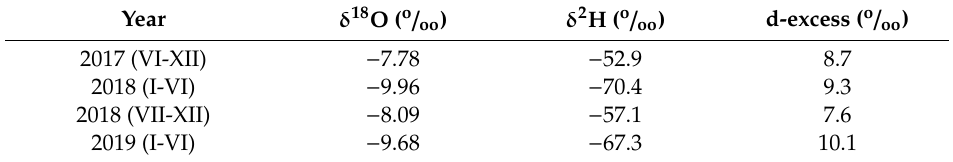
Table 6. Yearly averaged isotopic composition of precipitation at the rain gauge in Hrašˇcica (177 m a.s.l.). Year δ 18 O ( o / oo